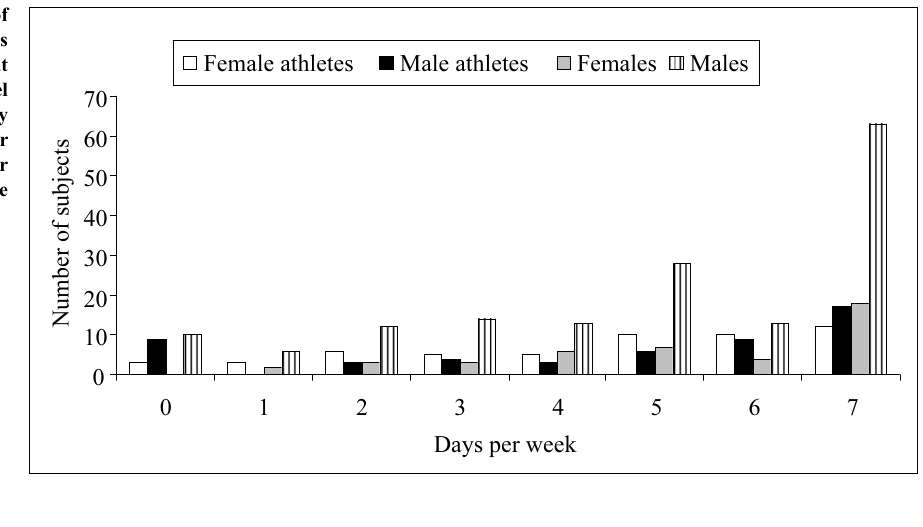
Figure 3. Frequency of walking, which